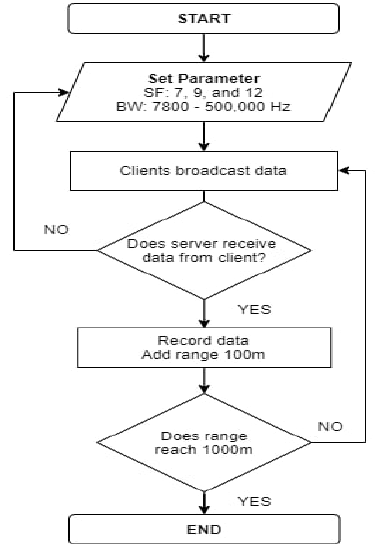
Figure 4. Testing scenario flowchart .